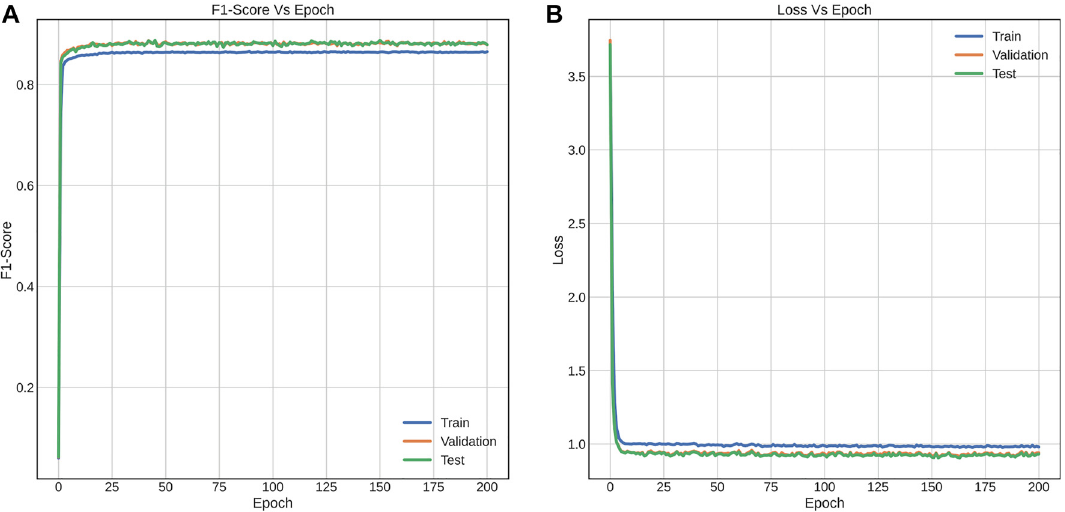
Figure 5: Training curves with FNN implemented for multiclass classification (A) and F1-score versus epochs (B) Loss versus epochs.